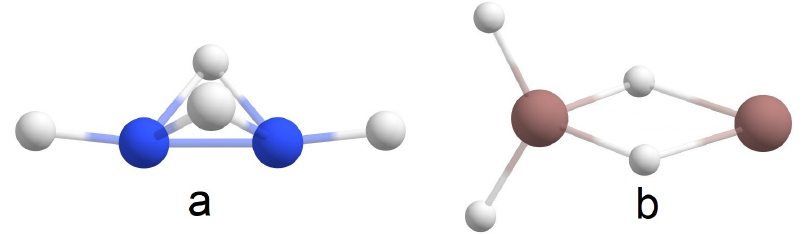
Figure 5. The comparison of the global minimum structures for ( a ) B 2 H 4 (according to [4]) and ( b ) In 2 H 4 .